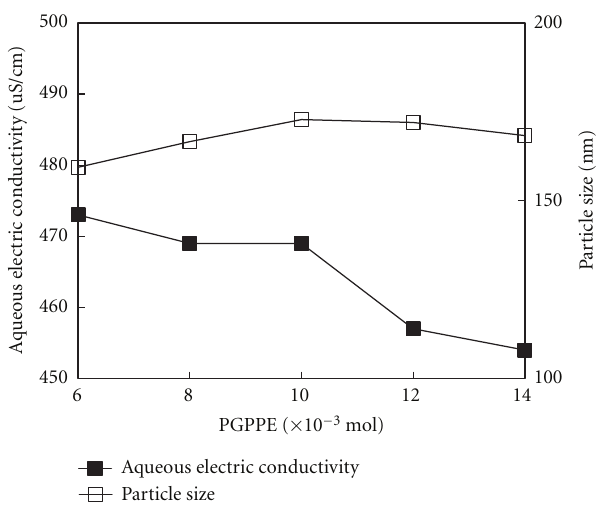
Figure 3: Aqueous electrical conductivity and average particle size of copper